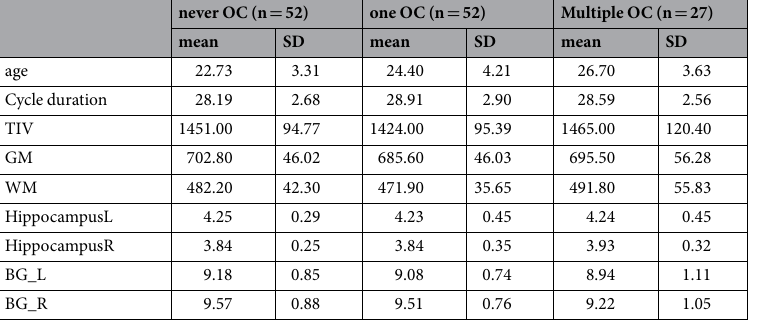
Table 1. Age, cycle duration and brain volumes of women who had never used oral contraceptives (OC), women who had used only one OC before and women who had used multiple contraceptive methids before. SD = standard deviation. TIV = total intracranial volume, GM = gray matter, WM = white matter, BG = basal ganglia, L = left, R =